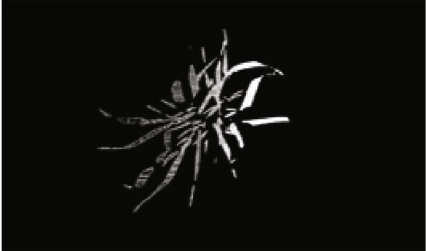
Figure 3: Segmentation algorithm used: none (input image from which wheat canopy will be extracted); description: original image to be segmented.